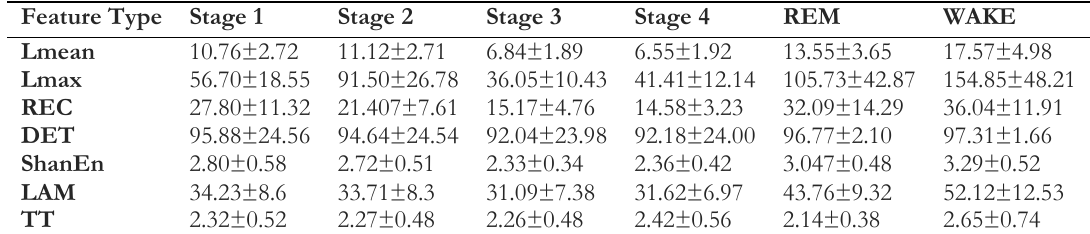
Table 2. The mean and standard deviation of nonlinear features at different stages of sleep.